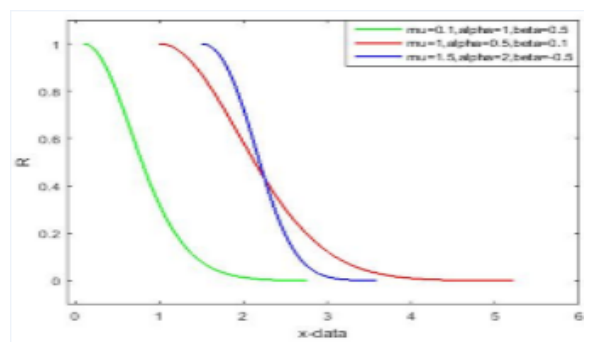
Fig. 3. Plot the Reliability